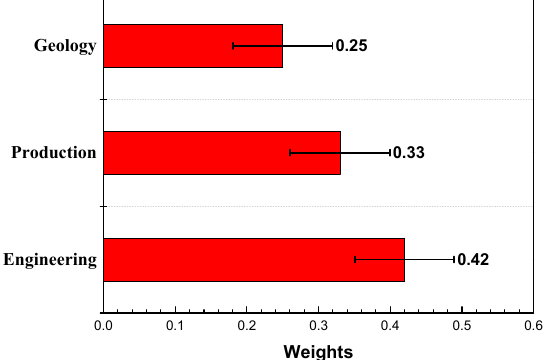
Figure 9. XGBoost output feature parameter weights.